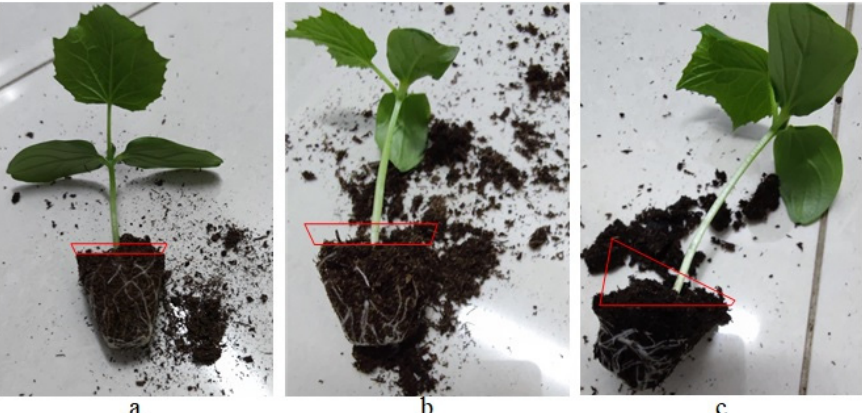
Figure 5. Effects of dropping damage with different treatments of cucumber seedlings: ( a ) seedling with less breakage; ( b ), ( c ) Seedlings with more breakage. Note: The area marked in the red line is the damaged area after the seedling was dropped.